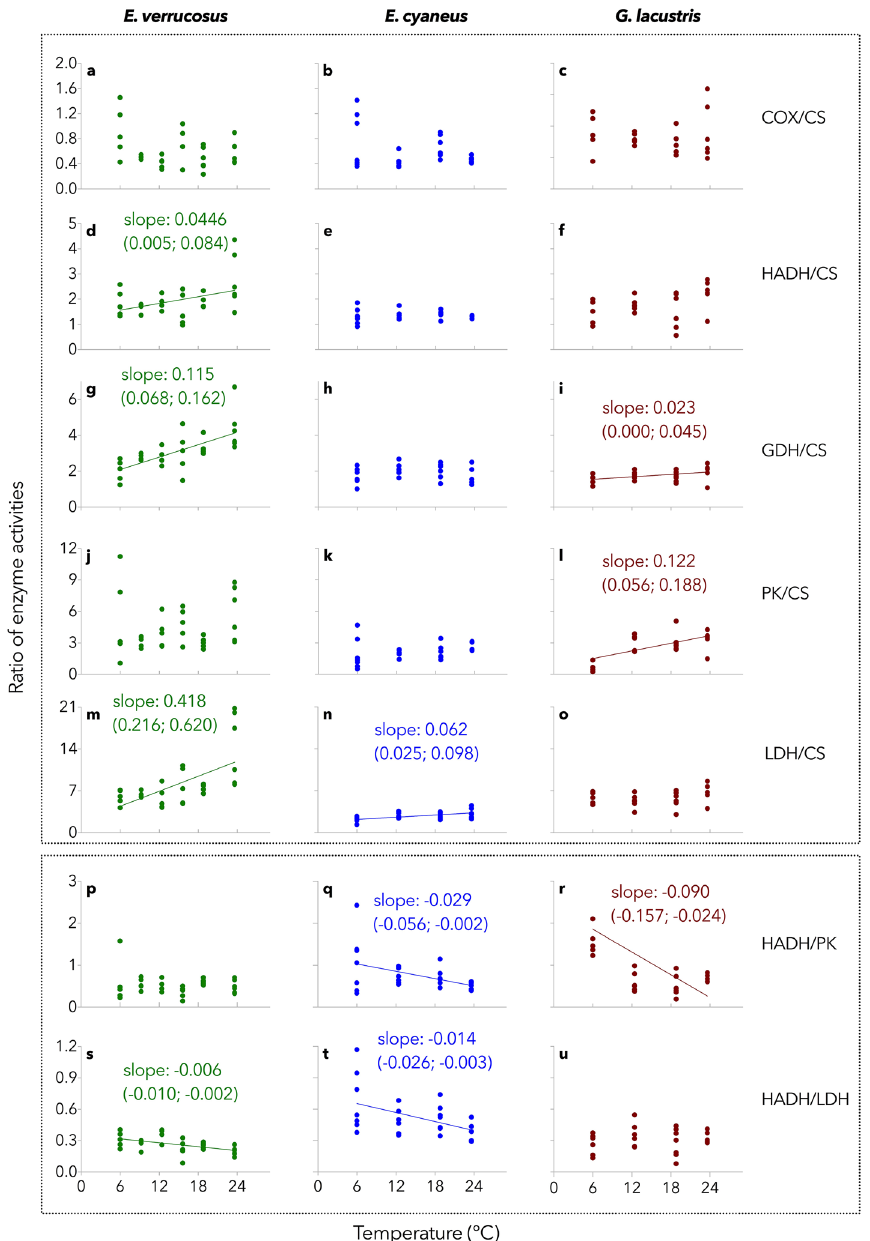
Figure 3. Ratios of maximum enzyme activities. Citrate synthase (CS), as the central hub in metabolism, connecting carbohydrates, lipids, and proteins, is used as denominator to decipher shifts in the use of metabolic fuels. Cytochrome-c-oxidase (COX) is a marker for aerobic capacity, pyruvate kinase (PK) and lactate dehydrogenase (LDH) are used as indicators of anaerobic ATP generation, 3-hydroxyacyl-CoA dehydrogenase (HADH) is essential for fatty acid metabolic processes, and glutamate dehydrogenase (GDH) represents a key link between catabolic and anabolic protein metabolism. A positive slope indicates a relatively increasing contribution of the respective enzyme (enzyme in the numerator position) to energy metabolism along with warming. Oppositely, a negative slope indicates a decreasing contribution of the enzyme in the numerator position to metabolic processes. For a comparison of fatty acid-based metabolism and glycolysis, HADH activity was related to PK and LDH activity. Measurements of enzyme activities in the tissue extracts of E. verrucosus , E. cyaneus , and G. lacustris were performed at the respective sampling temperatures. Individuals of all species were exposed to a gradual temperature increase (0.8 °C d −1 ). Slopes and their 95% confidence intervals are indicated when simple linear regression analysis revealed that slopes were significantly different from zero (p < 0.05). Dots represent ratios of individual animals (one data point, i.e., HADH/PK ratio with the value of 6 in the data set G. lacustris— 6 °C, is not depicted to avoid reducing the resolution of the panels but was not removed from any analysis); n =